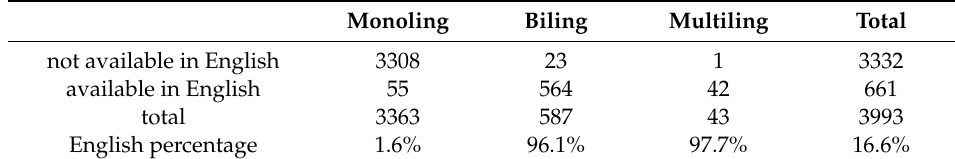
Table A26. English language availability (hu).